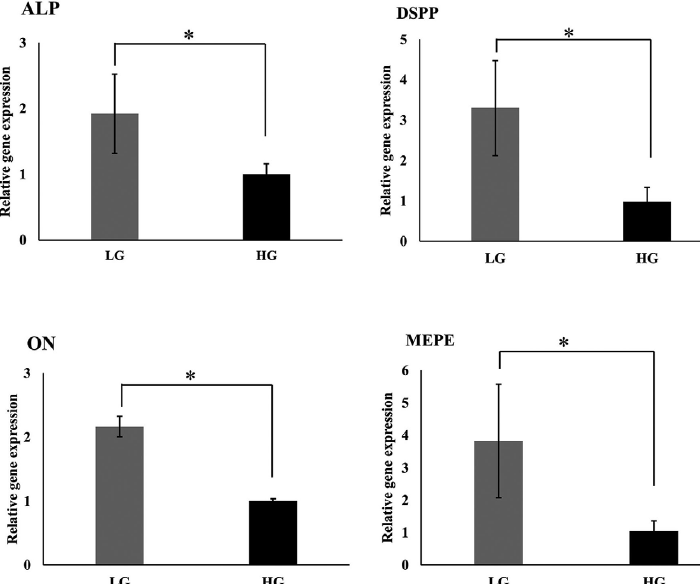
Figure 7- RT-qPCR validation of mineralization-related genes on day 14. Alkaline phosphatase (ALP), dentin sialophosphoprotein (DSPP), matrix extracellular phosphoglycoprotein (MEPE) and osteonectin (ON), Low glucose (LG) and High glucose (HG). * indicates a statistically significant difference between groups